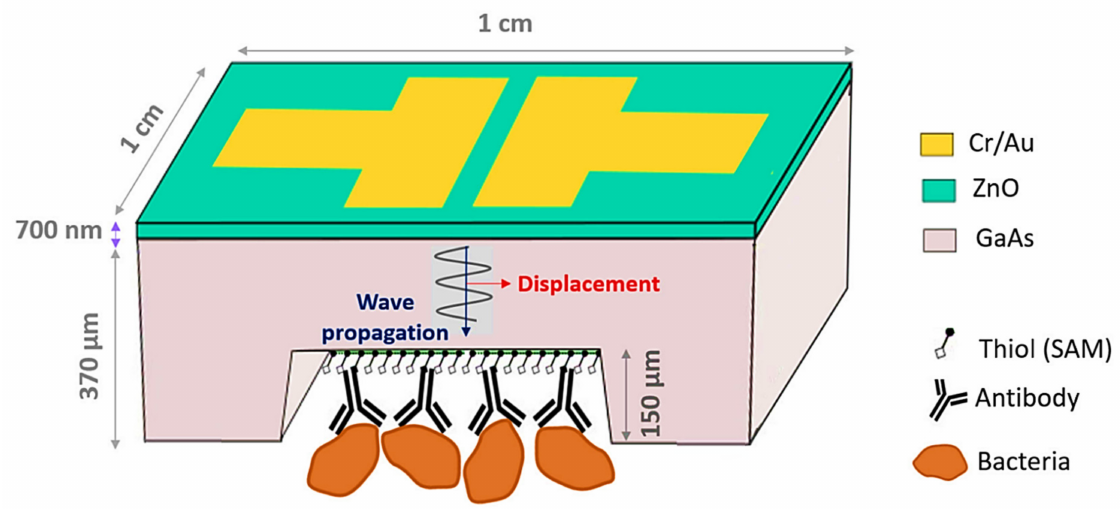
Figure 8. Schematic construction of ZnO/GaAs BAW nanosensor for identification of E. coli. Reprinted from Ref. [105].